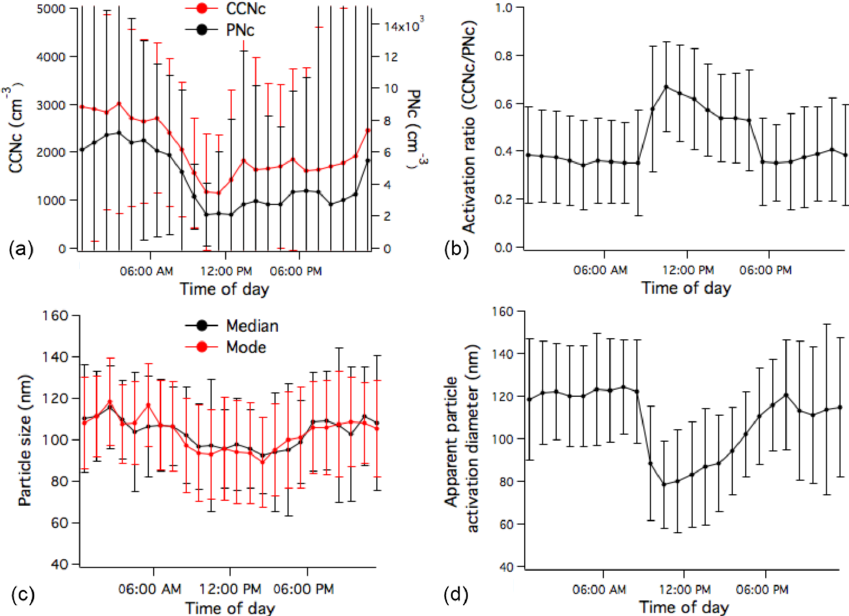
Figure 3. The diurnal trends of (a) the total cloud condensation nuclei concentration (CCNc) and particle number concentration (PNc), (b) the activation ratio at 0.5% supersaturation, (c) the median and mode of the particle size distribution, and (d) the apparent activation diameter. All reported values are the median of the hourly averaged data for the sampling period and the error bars represent the standard